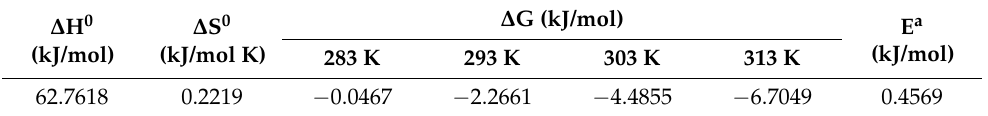
Figure 9. Thermodynamic of the adsorption of CPC onto AOE: ( a ) estimation of thermodynamic parameters; ( b ) estimation of the activation energy. Table 6. Thermodynamic parameters of the adsorption of cephalosporin C onto AOS . Δ H 0 (kJ/mol) Δ S 0 (kJ/mol·K)